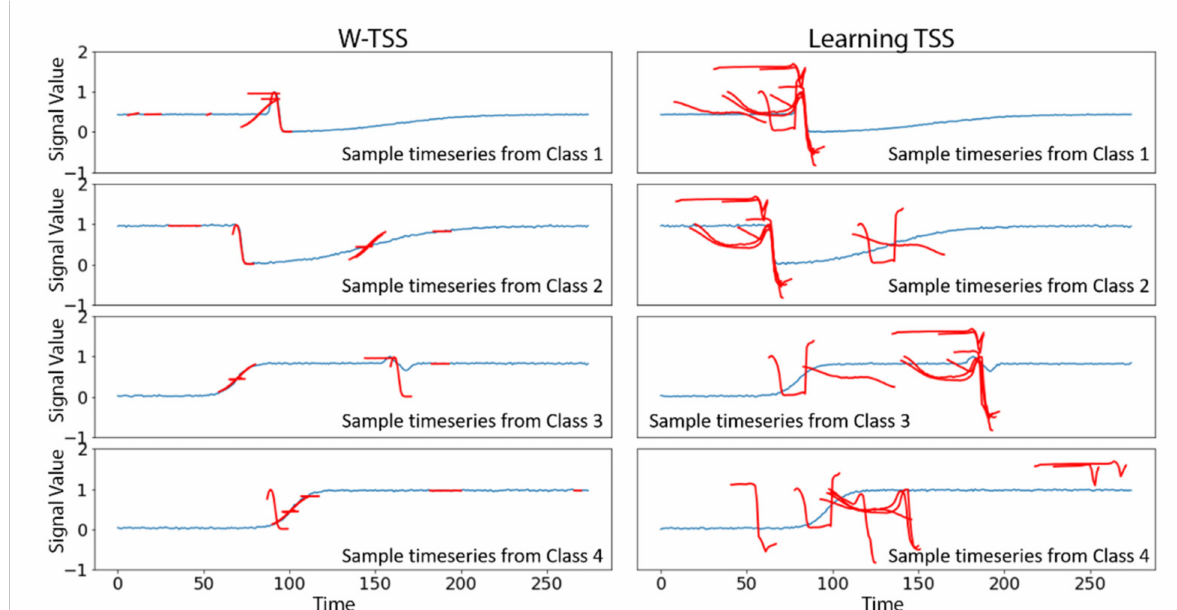
Figure 7. Shapelets (in red) discovered in the TRACE dataset by W-TSS ( left ) and learning TSS ( right ), displayed at the best matching location of an example time series (in blue) from each of the four classes.